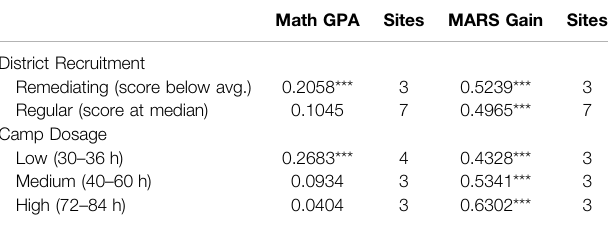
TABLE 5 | Estimated impacts on math GPA and gains on MAC/MARS among subgroups of program sites. Math GPA Sites MARS Gain Sites District Recruitment Remediating (score below